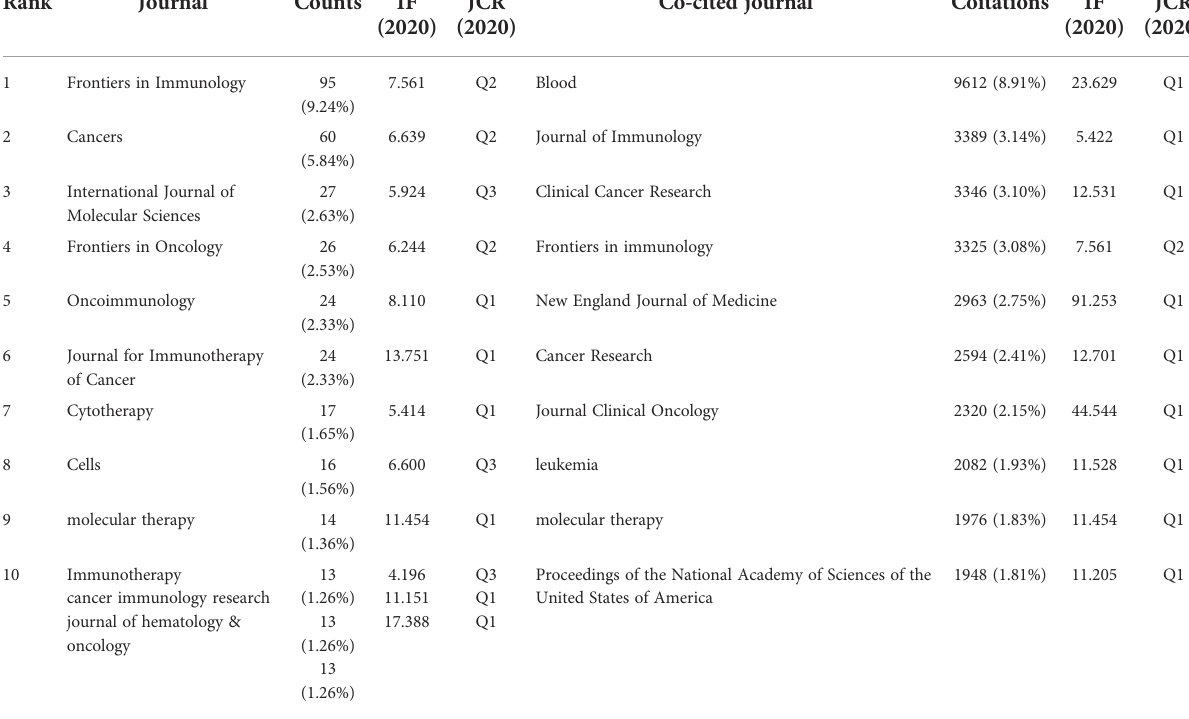
TABLE 2 The top 10 journals and co-cited journals related to CAR-NK